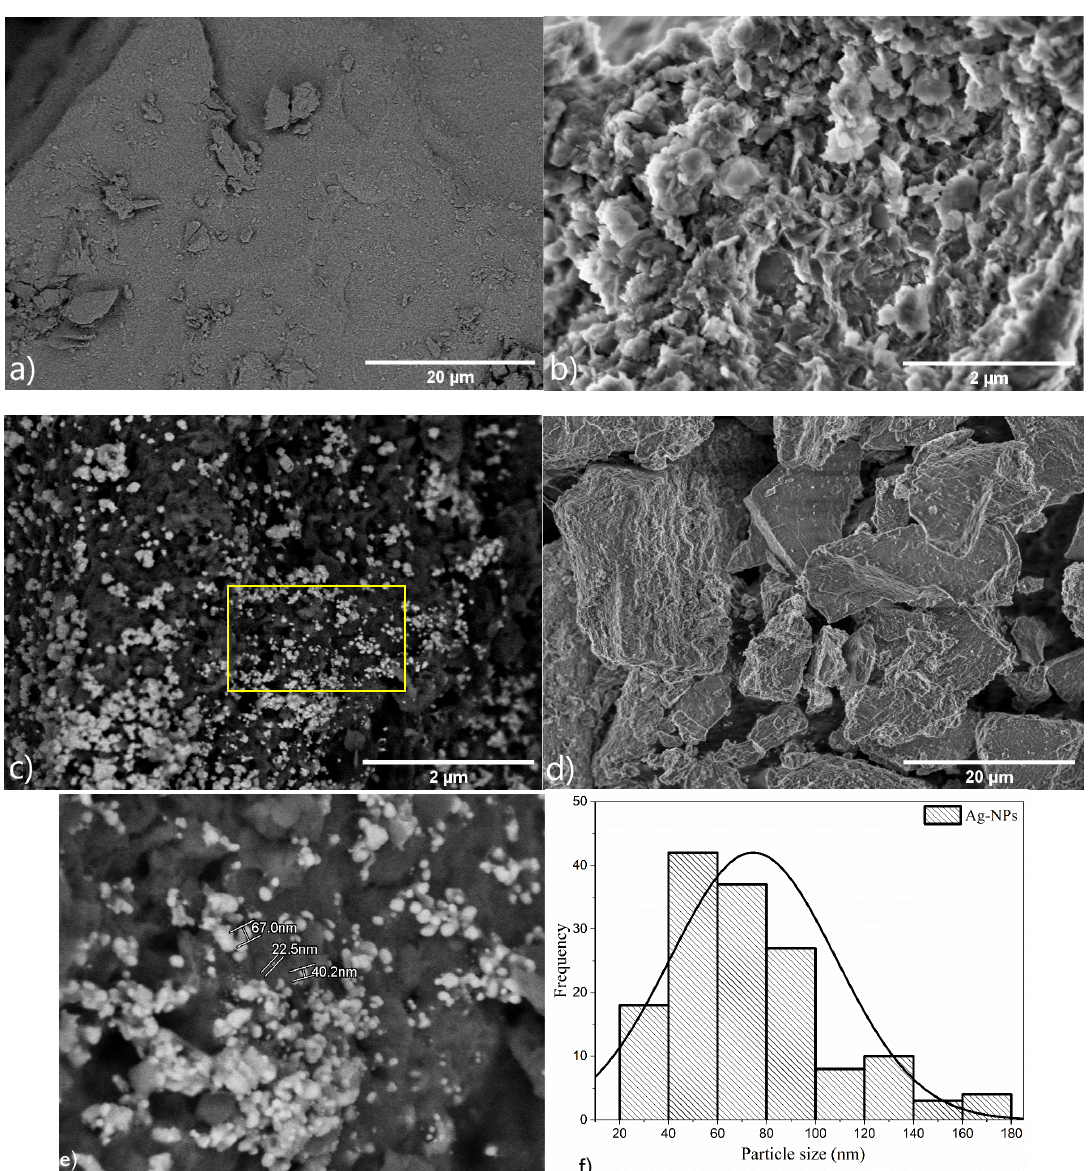
Figure 4. Scanning electron microscopy images of samples: ( a ) boehmite (LA detector), ( b ) boehmite (SE detector) ( c ) Ag-Boehmite (LA detector), ( d ) Ag-Boehmite (SE detector), ( e ) Ag-Boehmite (LA detector), the image is the magnification of the region inside the yellow rectangle in image ( c ), the bight nanostructures are Ag nanoparticles, and ( f ) histogram of Ag particle size distribution, the diameter of the Ag particles was measured on image (e). Table 2. Chemical composition of the samples according to EDS characterization.